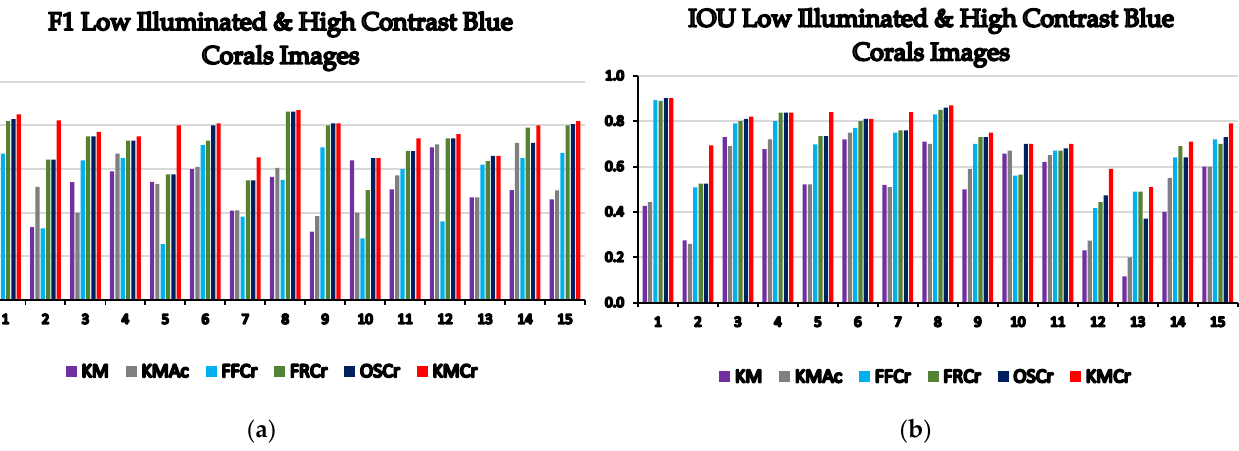
Figure 16. The results of evaluating the tested segmentation algorithms using low illuminated and high contrast blue coral images. Images (1 – 8) had two categories, and (9 – 15) had three categories: ( a ) F1-score; ( b ) IOU.